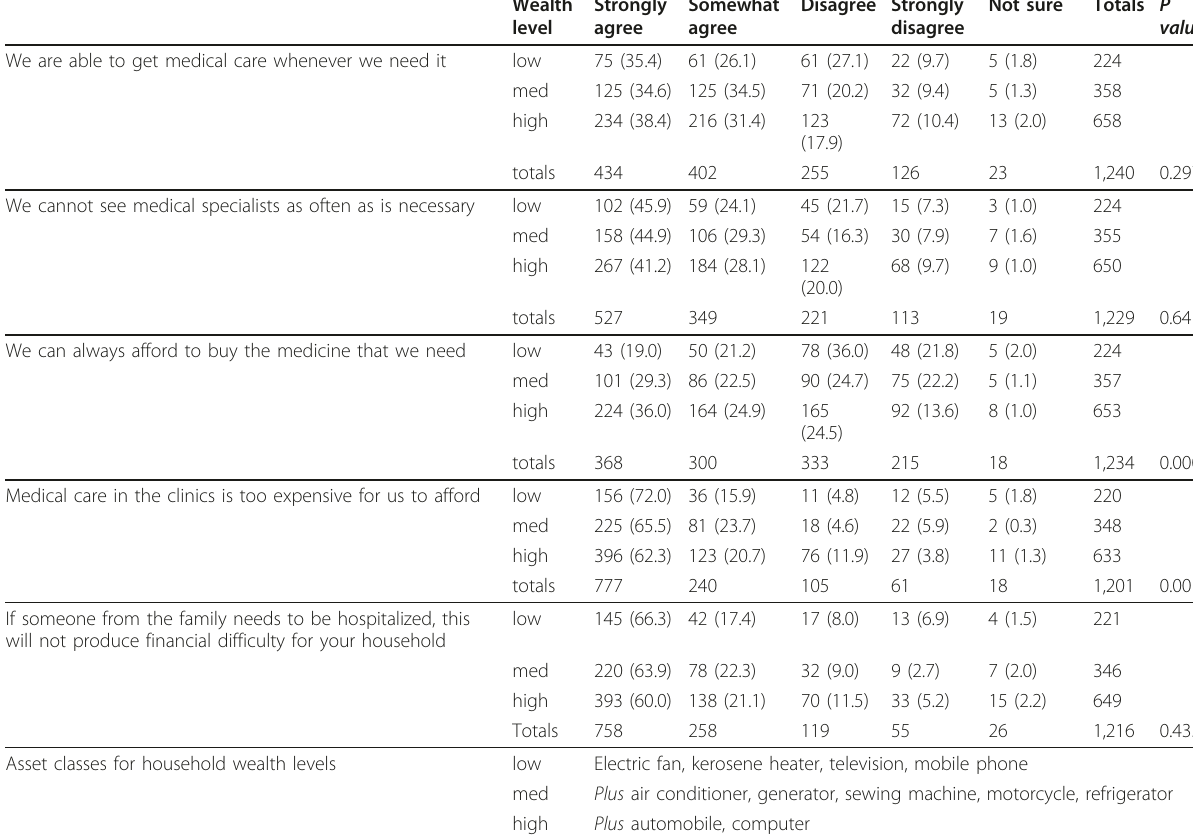
Table 3 Perceived household access to care by wealth levels, measured by household assets